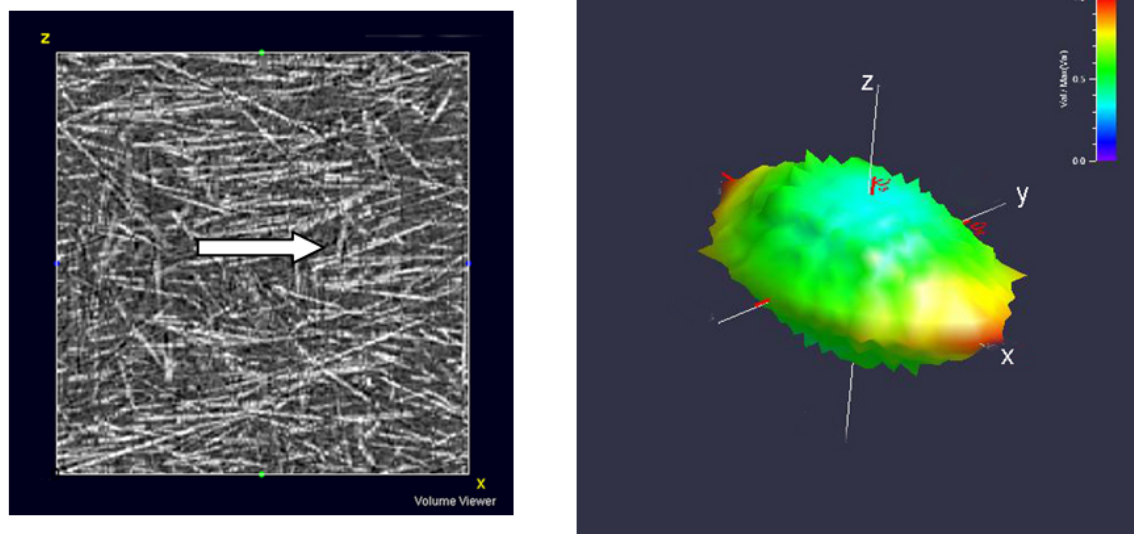
Figura 12: Zona shell – Ricostruzione tomografica della distribuzione delle fibre (la freccia indica la direzione del flusso d’iniezione) e rappresentazione polare del MIL nelle direzioni di